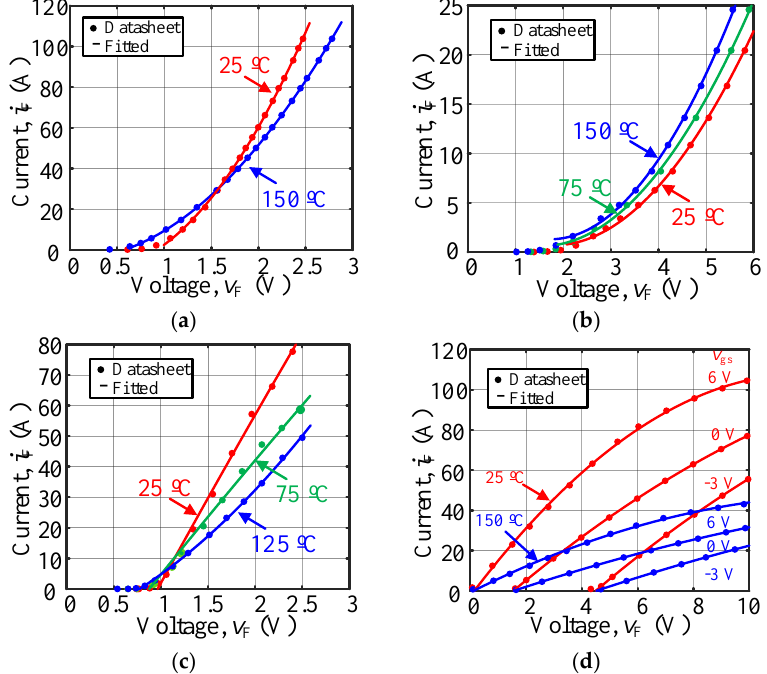
Figure 8. Diode static parameter extraction of ( a ) Si IGBT; ( b ) SiC MOSFET; ( c ) Si MOSFET; ( d ) eGaN HEMT.